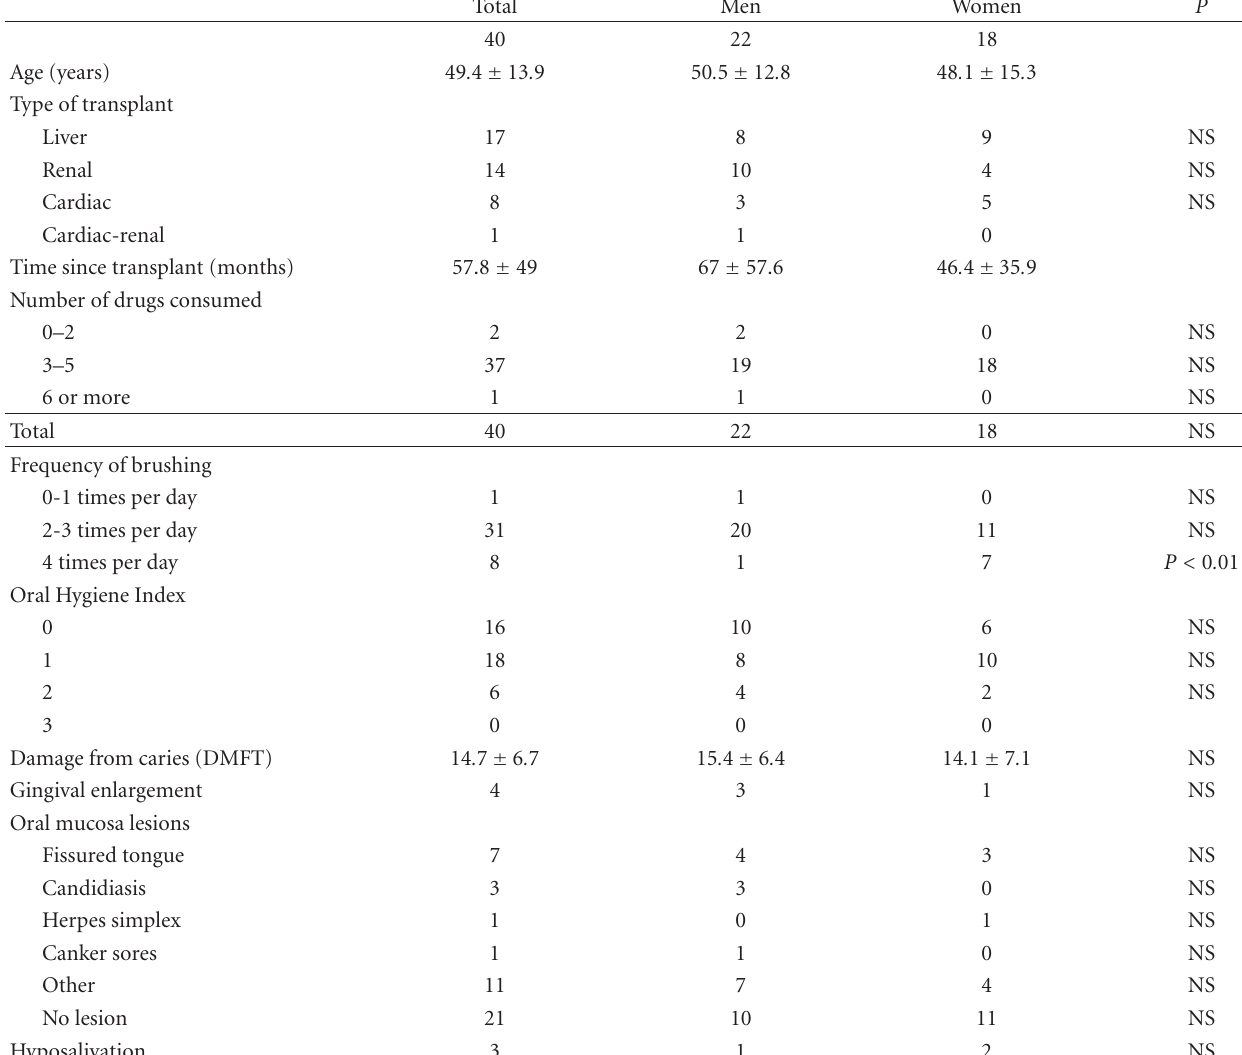
Table 1: Clinical and demographic characteristics of the study sample.